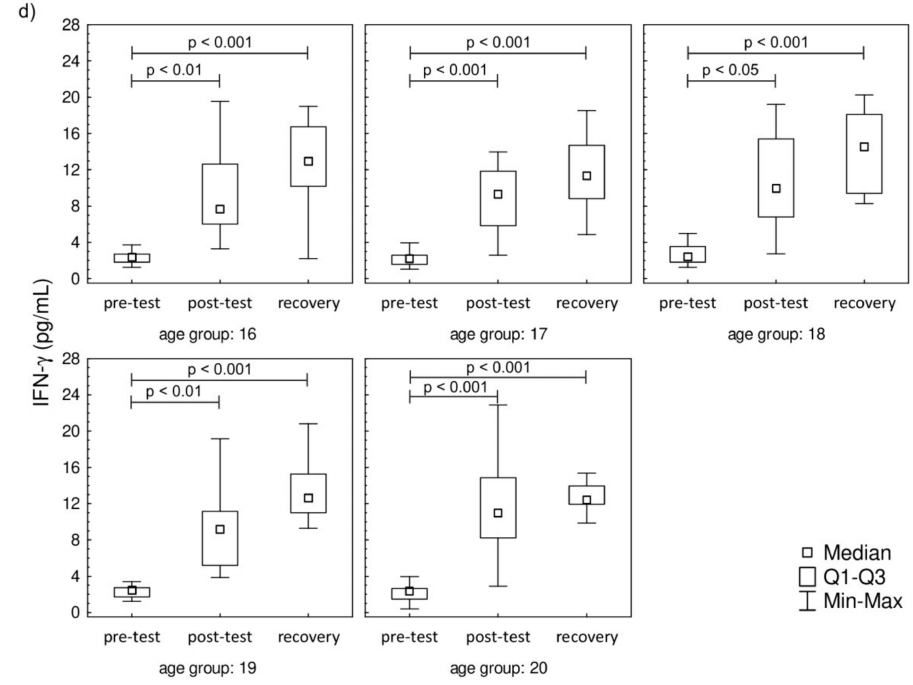
Figure 3. Median level of ( a ) interleukin-2 (IL-2), ( b ) interleukin-6 (IL-6), ( c ) interleukin-8 (IL-8), and ( d )interferongamma(IFN- γ )ofparticipants’plasmasamples. Significancelevelsofdi ff erencesobserved between analyzed time points (pre-test vs. post-test vs. recovery) were assessed using Friedman’s analysis of variance for repeated measures followed by post hoc Dunn’s test with Bonferroni